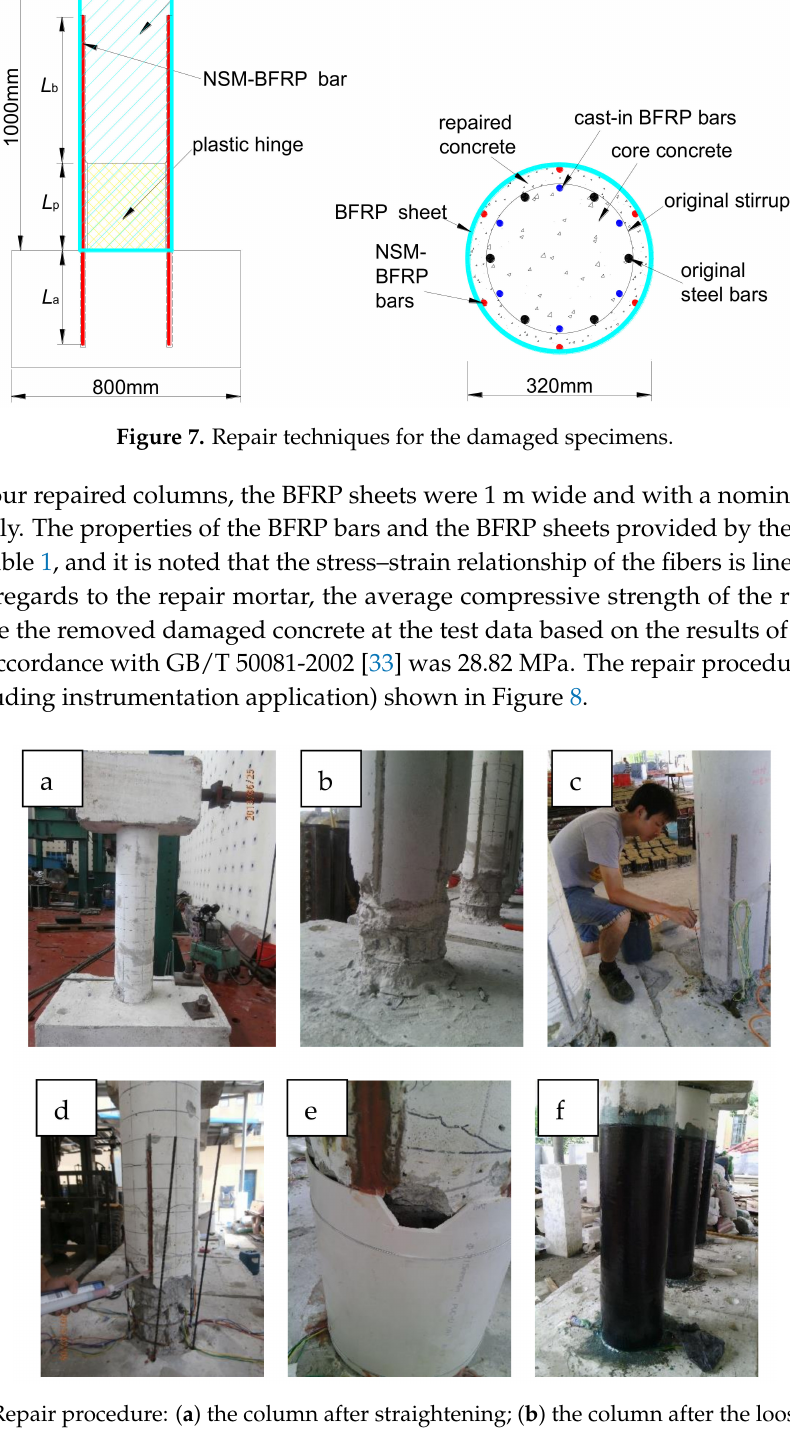
Figure 8. Repair procedure: ( a ) the column after straightening; ( b ) the column after the loose concrete removal and chiseling grooves; ( c ) clearing the holes and grooves; ( d ) injecting epoxy adhesive and placing the NSM BFRP bars; ( e ) the repair mortar placement; and ( f ) the BFPR sheet